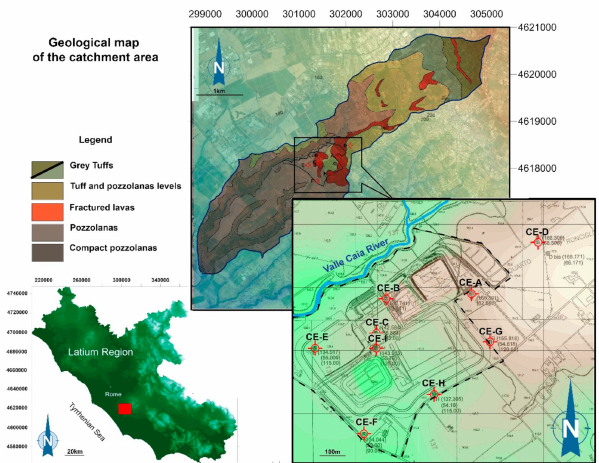
Figure 1. Study area and sampling site location map: the catchment basin is highlighted with a blue line (intermediate map); the dashed black line shows the site (detail map) where each red circle represents a sampled piezometer (CE-A, CE-B, CE-C, CE-D, CE-F, CE-G, CE-H, and